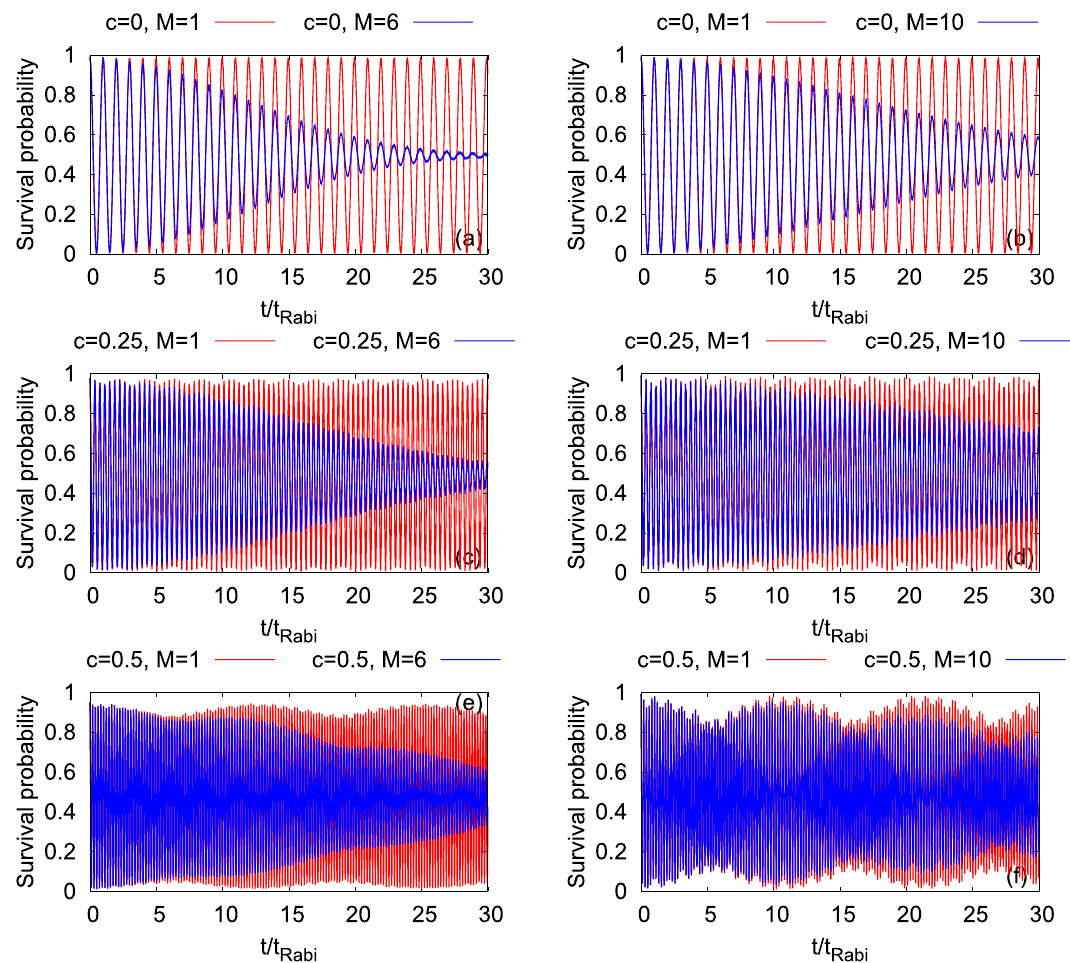
Figure 3. Dynamics of the survival probability of (cid:31) G (left column) and (cid:31) Y (right column) in the left well 10 bosons with the interaction parameter of longitudinally-asymmetric 2D double-well potential of N = 0.01 π . The first row presents the results for the symmetric double-well potential. Second and third � = 0.25 and 0.5, rows show the survival probabilities at the resonant tunneling with asymmetry parameter, c = 6 time- 1 signifies the mean-field results. The many-body dynamics are computed with M respectively. M = = 10 time-dependent orbitals for (cid:31) Y . We show here dimensionless quantities. dependent orbitals for (cid:31) G and M = Color codes are explained in each panel.